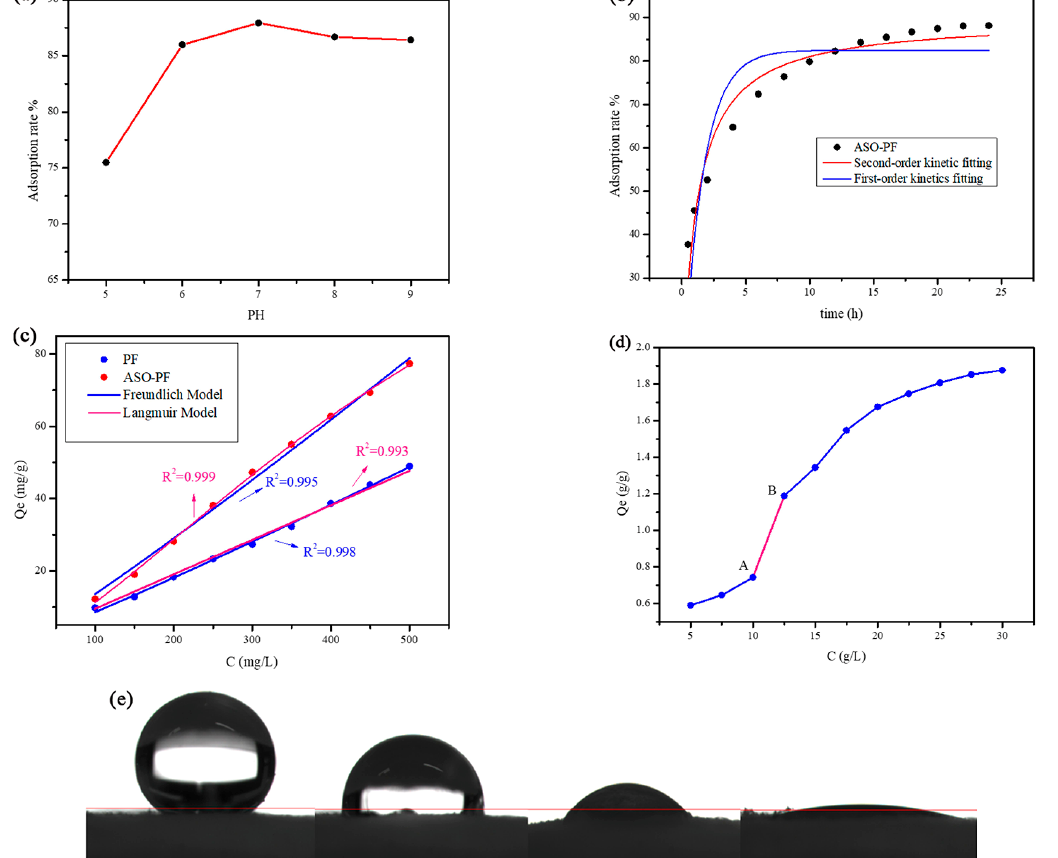
Figure 7. Adsorption behaviour of ASO-PF on phenol solution. ( a ) Effect of pH on the adsorption capacity of ASO-PF on phenol, ( b ) kinetic fitting of ASO-PF adsorption efficiency with time, ( c ) isothermal adsorption curve of ASO-PF adsorption capacity with concentration, ( d ) adsorption capacity of ASO-PF in high concentration phenol solution, and ( e ) contact angle of ASO-PF surface at a concentration of 12.5 g·L − 1 of the contacted solution.